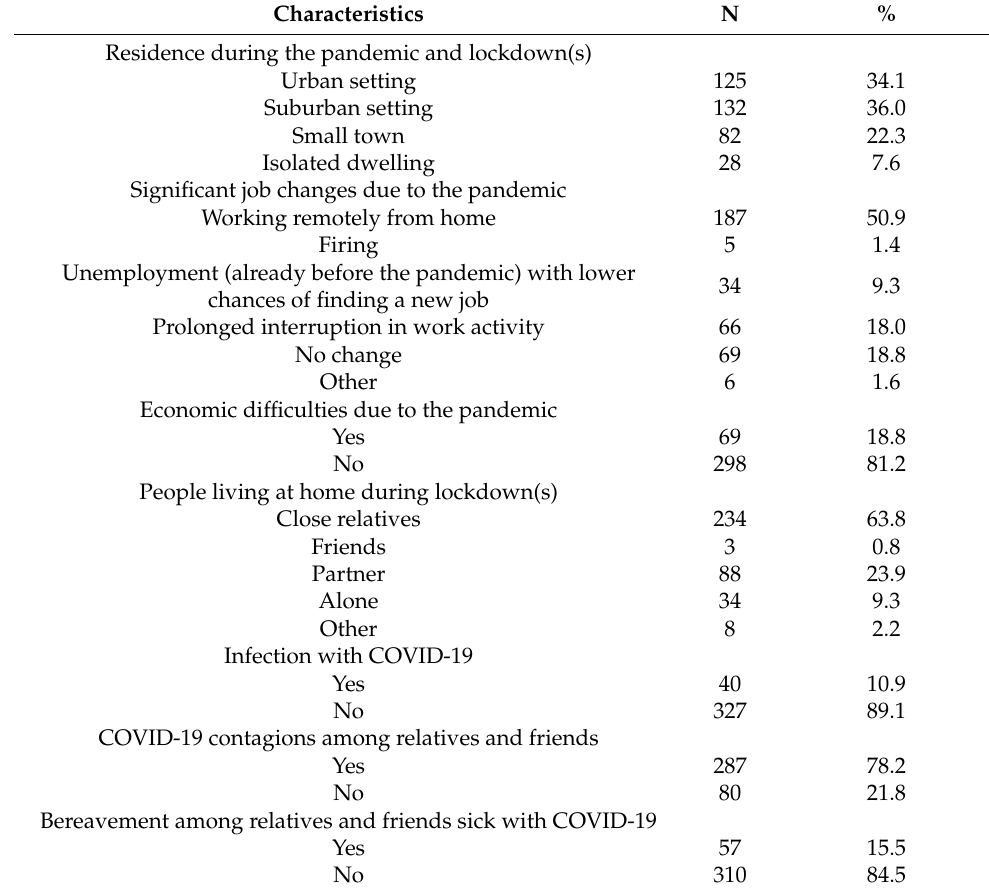
Table 1. Demographics and COVID-19-related